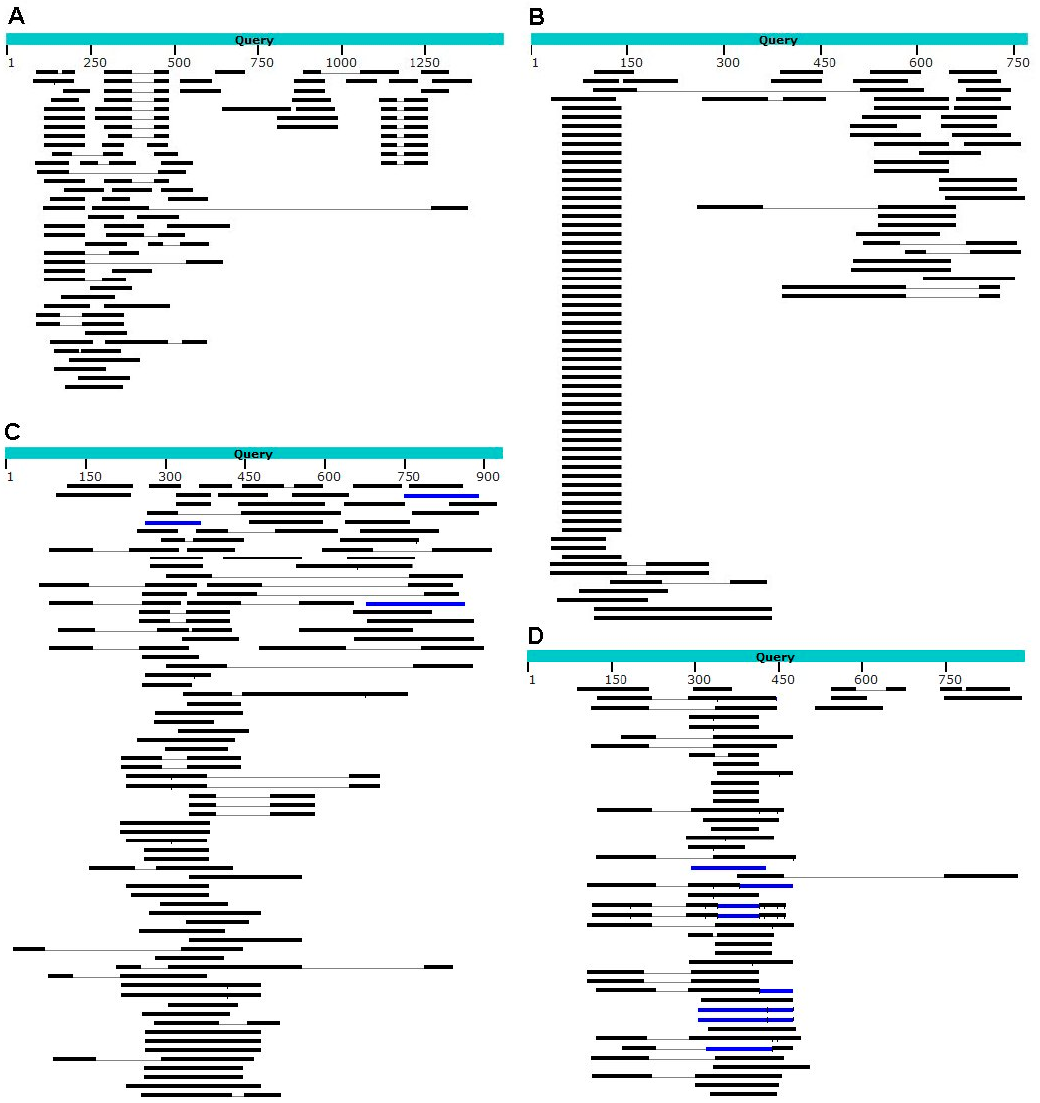
Figure 1. Distribution of best matches produced by TBLASTX on the P. spumarius PSPU08 genome using query sequences of nudivirus PIF proteins. Top hits of N. lugens nudivirus PIF-1 ( A ) and PIF-2 from nudiviruses of Drosophila sp. ( B ), Macrobrachium rosenbergii ( C ), and D. melanogaster ( D ). NCBI accession numbers of query sequences are KJ566575.1 ( A ), MT496843.1 ( B ), JQ804993.1 ( C ), and NM_169147.2 ( D ). Colours indicate levels of NCBI alignment scores (black: <40; blue: = 40–50)